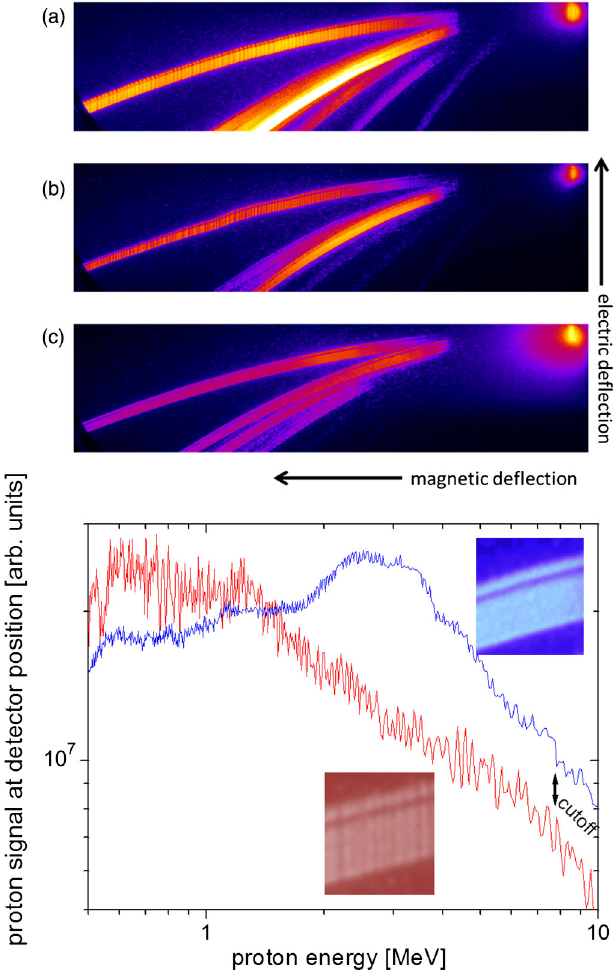
FIG. 3. Upper part: Recorded detector images of the ion spectra (parabolic traces) in the same false color scaling: (a) 5 μ m Ti foil, HC, circular polarization, spectrometer slit 240 μ m, (b) 5 μ m Ti foil, HC, linear polarization, spectrometer slit 50 μ m, and (c) 30 nm plastic foil (UHC, linear polarization, parameters cf. the text), spectrometer slit 50 μ m; lower part: scans of proton traces from (a) and (c): 5 μ m Ti foil (HC, circular polarization, red line; cf. Fig. 1), 30 nm plastic foil (UHC, linear polarization, parameters cf. the text) (blue line); inset: magnified part of signal traces. The proton signals are pixel counts at the pixel position (at the calculated energy position) of the detection system.